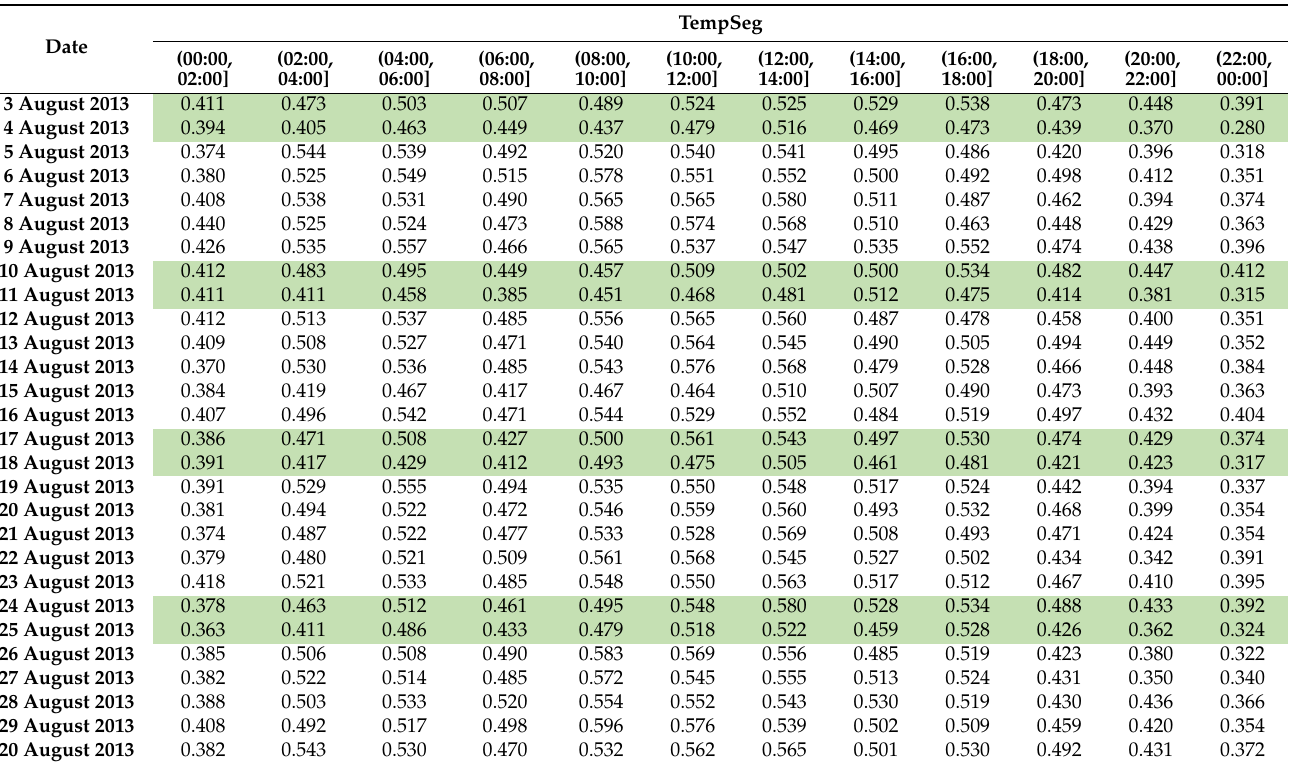
Table 4. Average calculated speed limit rate by day and TempSeg of all the cells, MaxSpeed = 50 km/h (weekends in